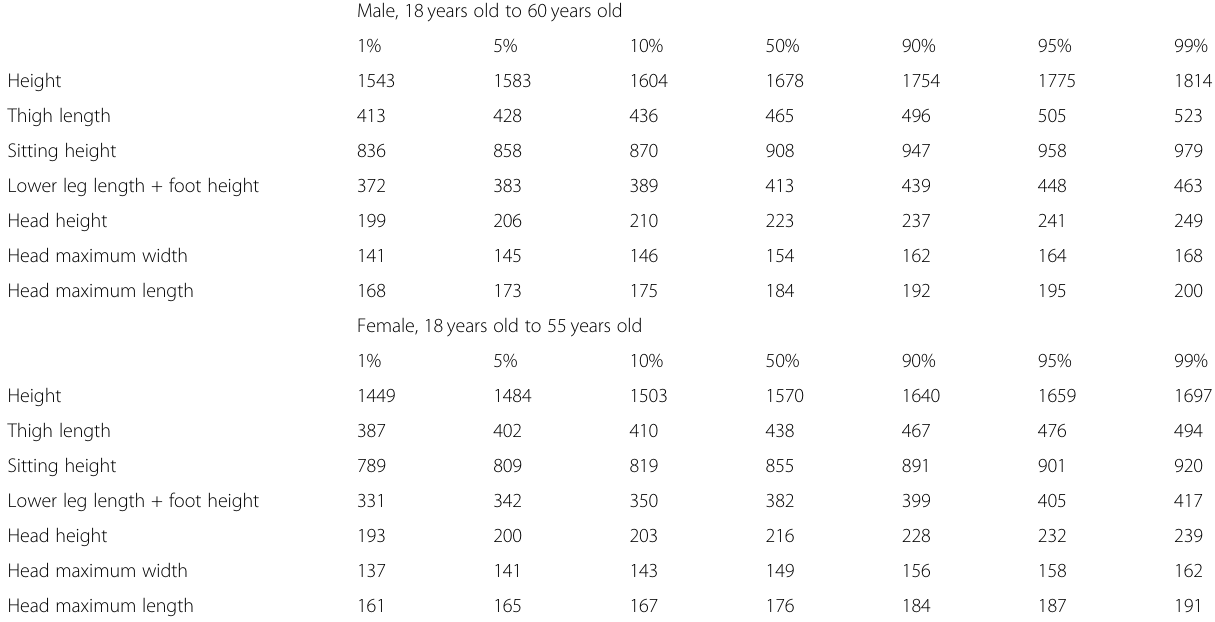
Table 1 Chinese adult body size